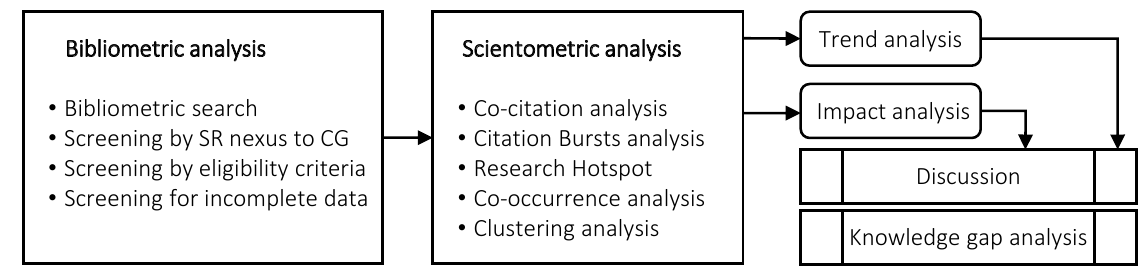
Figure 1. Summary of the overall research methodology employed